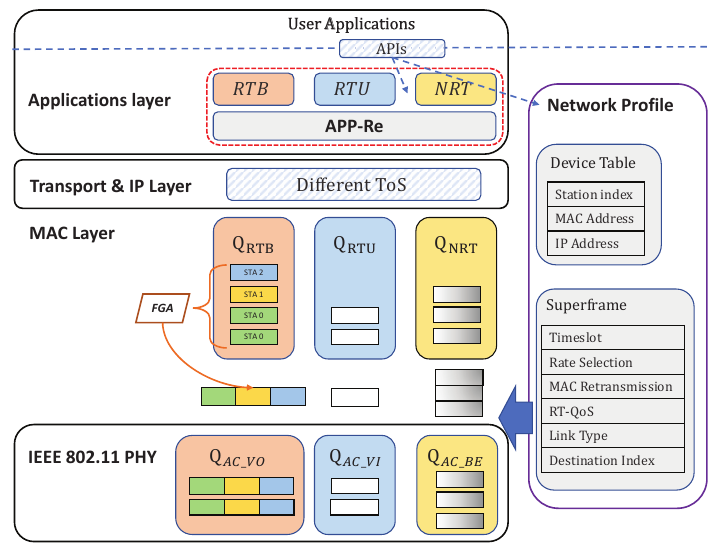
Figure 1. Overview of framework architecture for